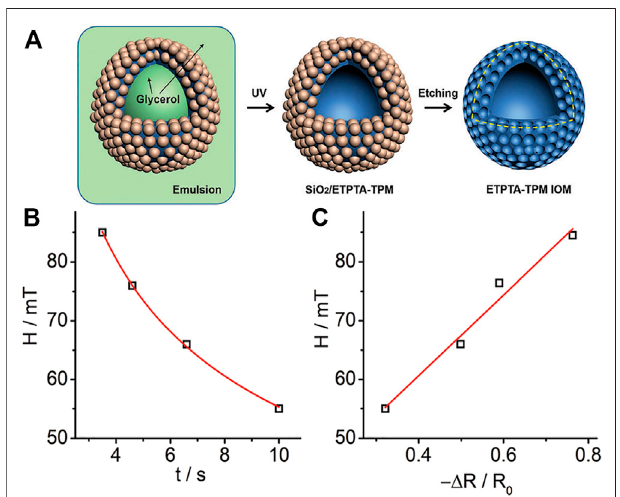
FIGURE12|(A) SynthesisofhollowETPTA-TPMIOMsbyUVcuringthe doubleemulsiondropletinglycerolandetchingthesilicacontentfromtheshell of microspheres; (B) Negative correlation between fi eld strength (H) and quenchingtime (t);and (C) Positivecorrelation between fi eldstrength (H) and quenching ratio ( − Δ R/R0). Reprinted with permission from Zhang et al. (2017) Copyright © 2017 Royal Society of